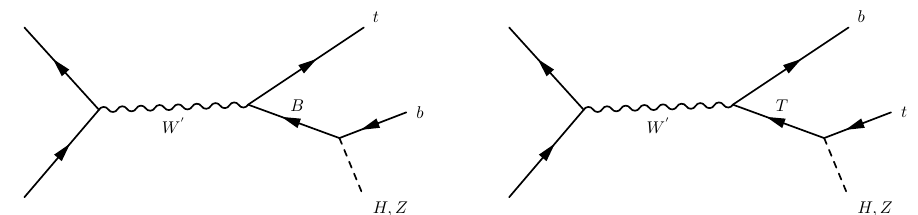
Figure 9. Feynman diagrams at lowest order for the production of a W (cid:48) boson decaying to a vector-like quark and a top or bottom quark